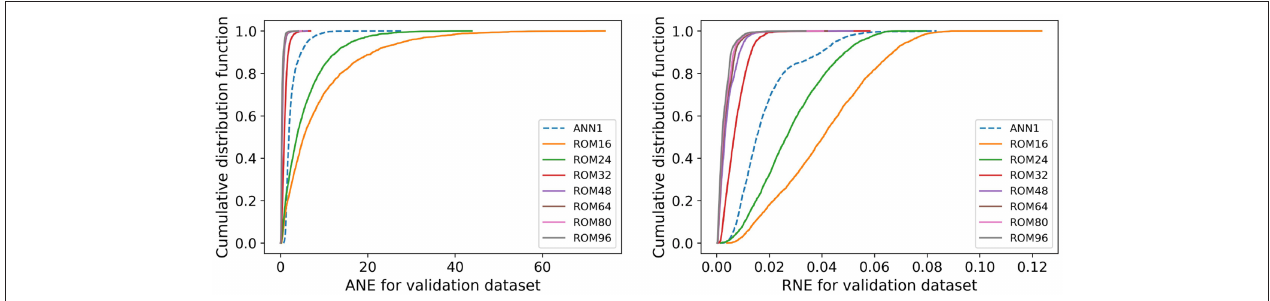
FIGURE 5 | Cumulative distribution function of the errors of ANN and ROMs of dimensions 16 to 96: distribution of ANE e M a (Left) ; distribution of RNE e M r (Right) .